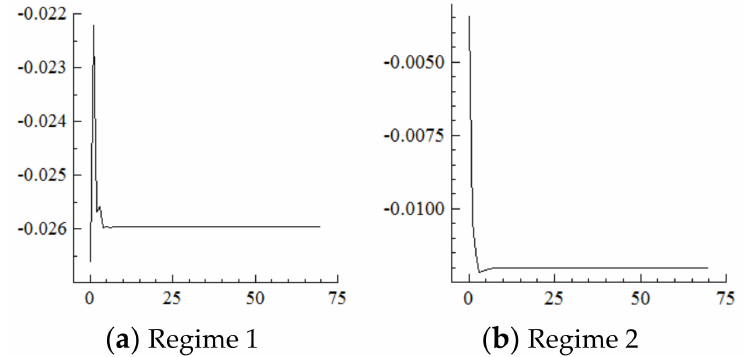
Figure 13. Cumulative Impulse Response of Export Upgrading to Population Aging Shocks.